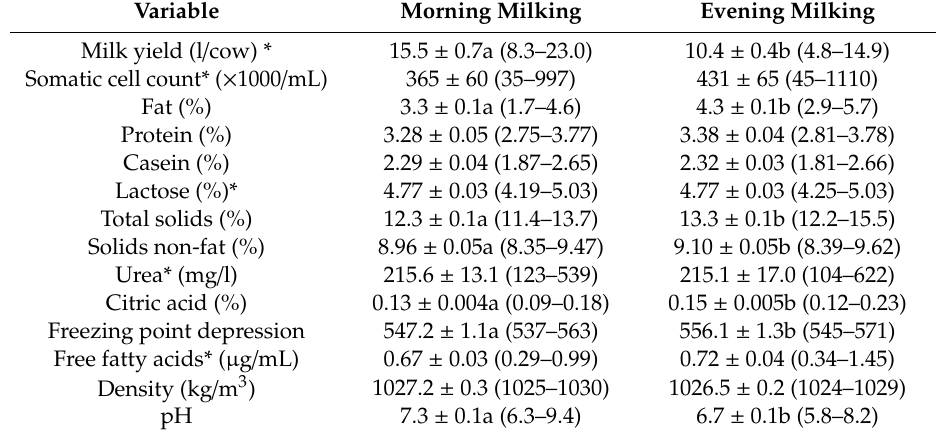
Table 2. Summaryofmilkyieldsandlaboratorytestingofmilksamplesobtainedfrom30Holstein-Friesian cows during the morning and evening milking periods. Ranges for each variable are given in parentheses.